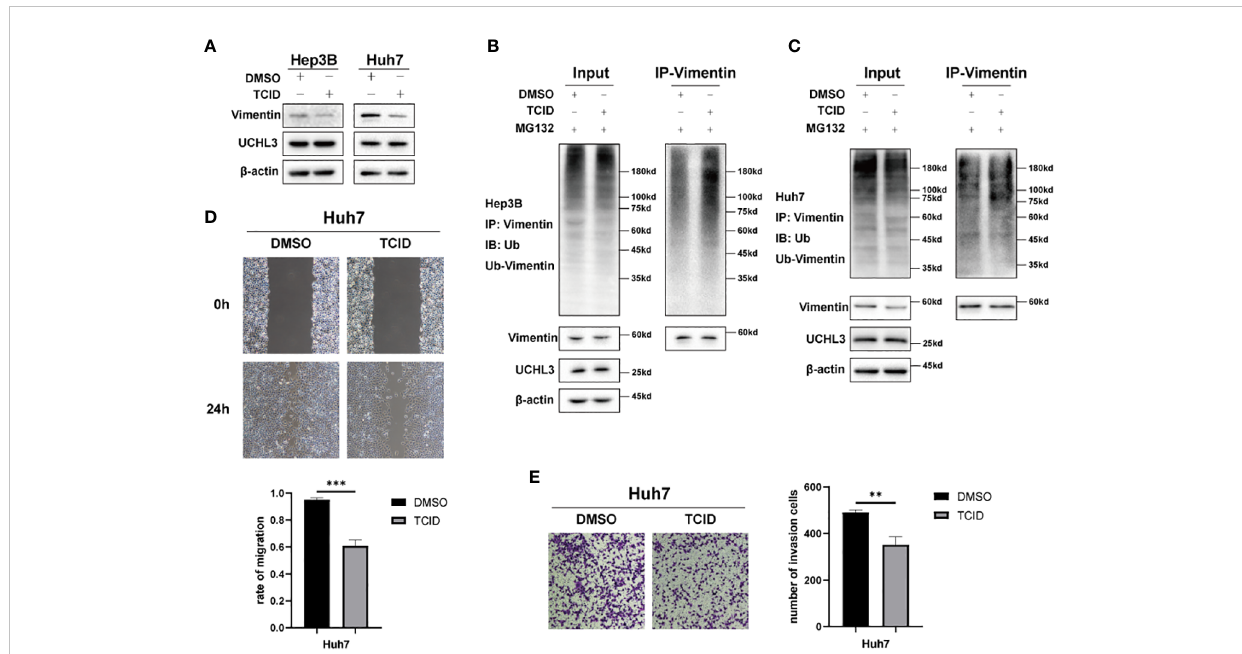
FIGURE 5 Inhibition of UCHL3 impaired HCC cell migration. (A) TCID treatment reduced Vimentin levels in Hep3B and Huh7 cells, as shown by Western blotting. (B) TCID treatment promoted Vimentin ubiquitination in Hep3B cells, as shown by Western blotting. (C) TCID treatment promoted Vimentin